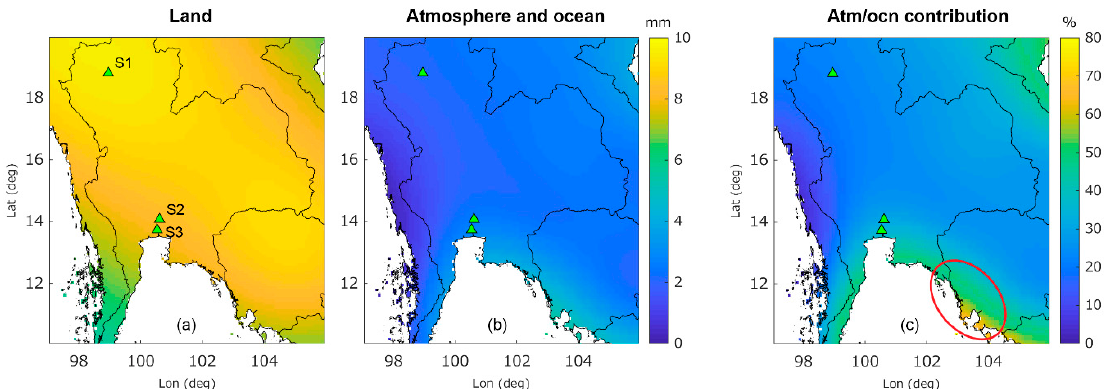
Figure 4. ( a , b ) The ∆ r estimate associated with land hydrology ( a ) and atmospheric and oceanic loadings ( b ). ( c ) The atmospheric and oceanic signals’ contribution (%) to the total ∆ r estimate. The contribution is computed as a ratio between the annual amplitude of the atmospheric and oceanic loadings and the annual amplitude of the total loadings. The evaluation sites (S1–S3) are shown as green triangles (see the site’s name in ( a )). The red oval in ( c ) illustrates the location where the atmospheric and oceanic signal contributions are significant.